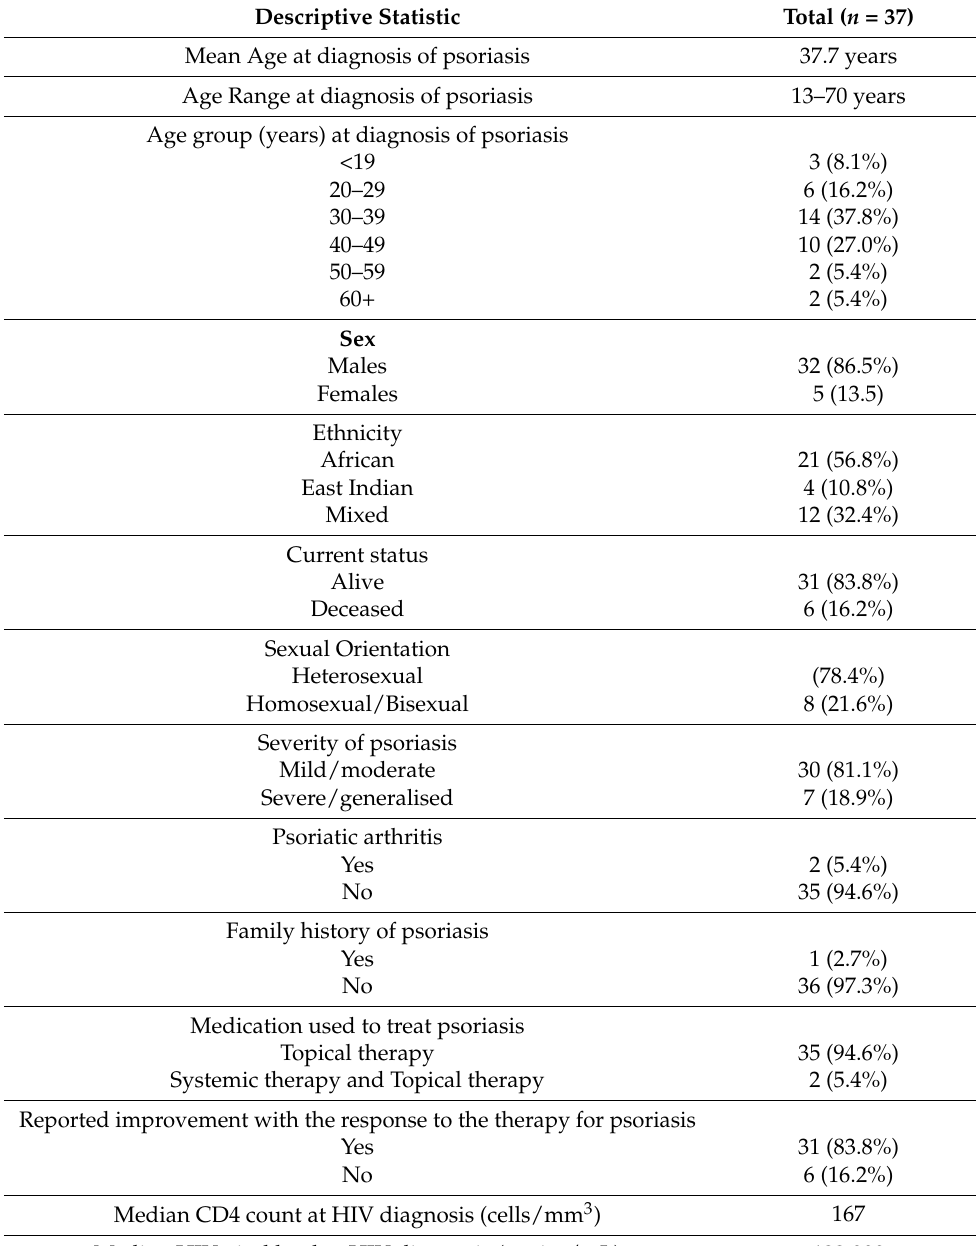
Table 1. Baseline characteristics of the Study Population ( n =